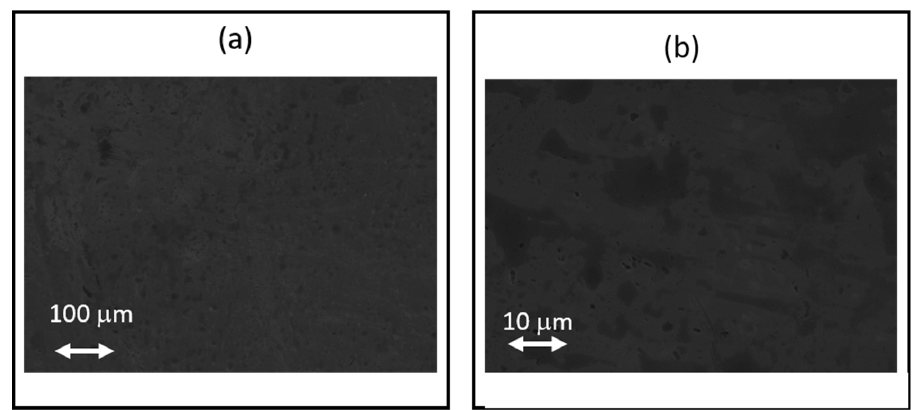
Figure 4. SEM images of the laser textured surfaces, processed at P = 1 W, v = 4 m/s ( a ); P = 1 W, v = 2 m/s ( b ); P = 13 W, v = 4 m/s ( c ); and P = 13 W, v = 2 m/s ( d ). SEM images were acquired at high magnification (3000×).